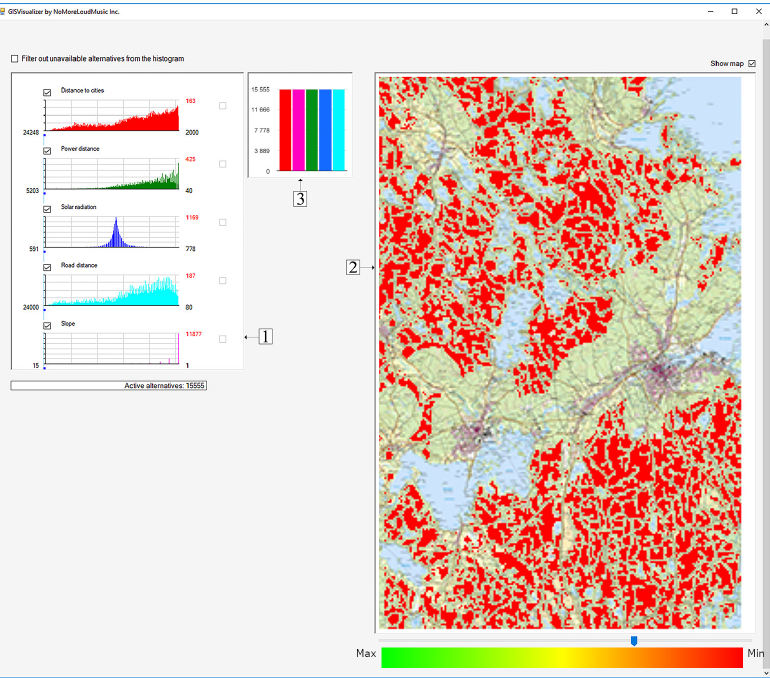
Figure 3. The main window of GISAnalyzer; initial setup, after the data for all criteria are loaded. The main unit of the application is the threshold adjustment unit . The threshold for each criterion is adjusted with a slider, and a histogram is used to represent the distribution of the values of the alternatives in terms of each of the criteria. When the threshold is adjusted for any of the criteria, the histogram is updated and the part filtered out by the change is coloured light grey. Throughout the adjustment process, the user can